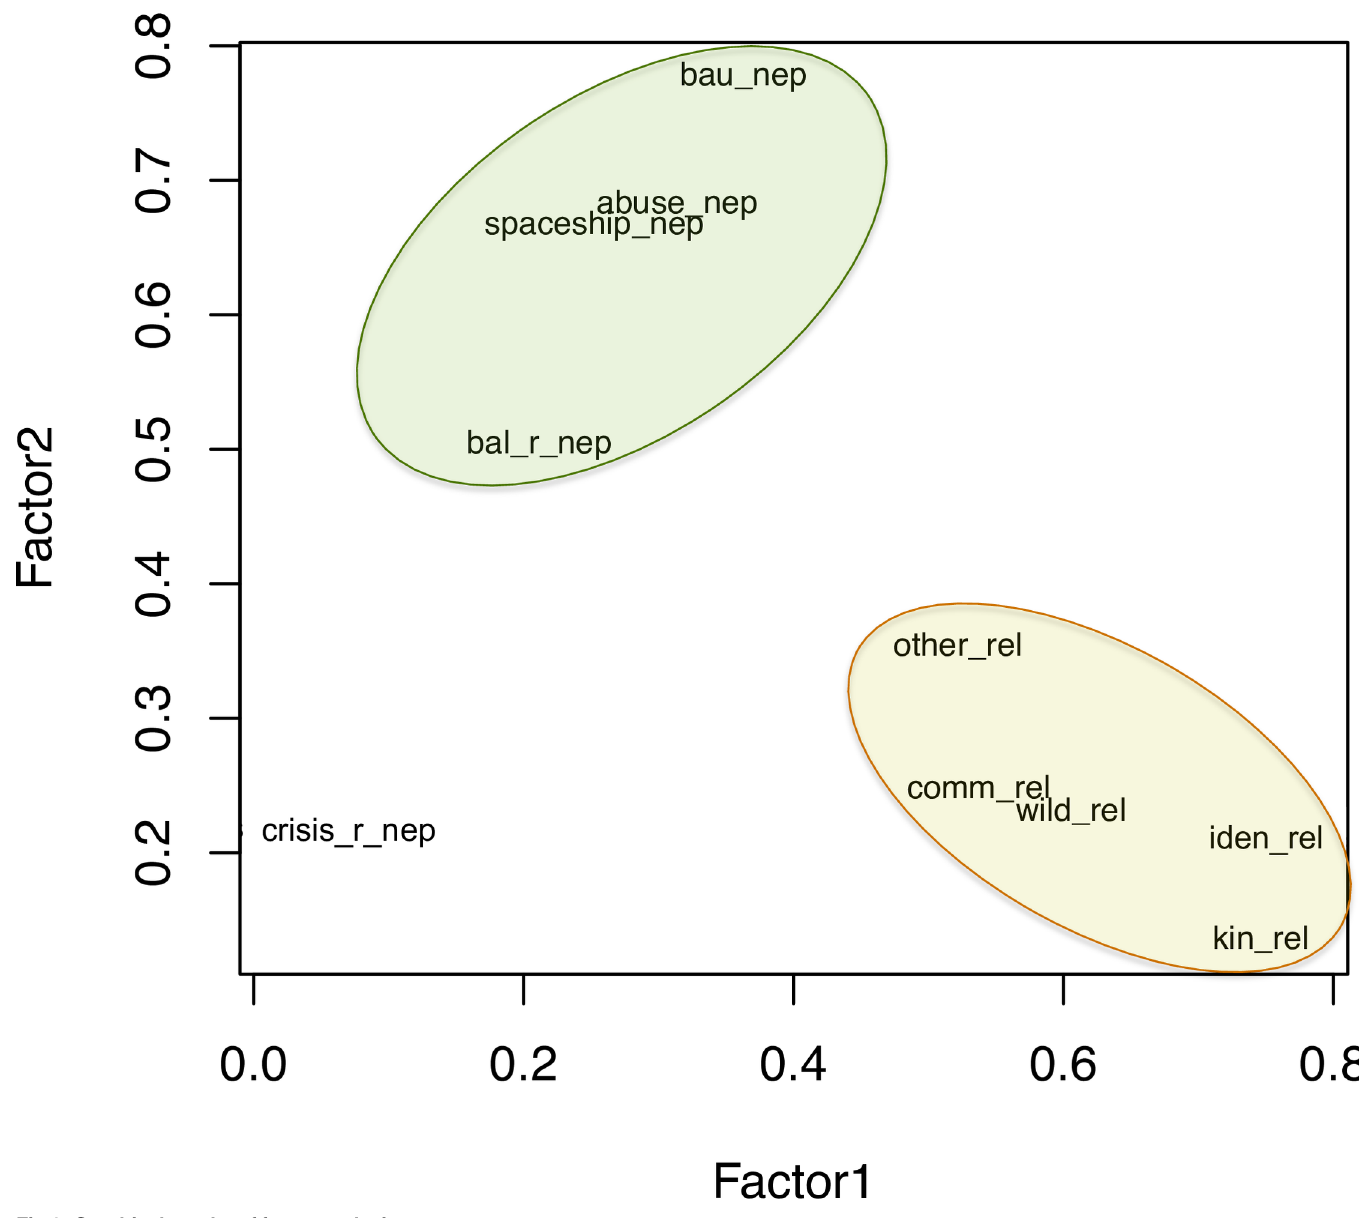
Fig 1. Graphical results of factor